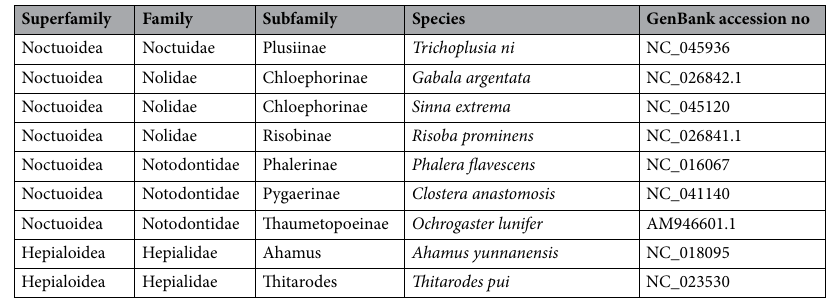
Table 3. Details of the Lepidopteran mitogenomes used in this